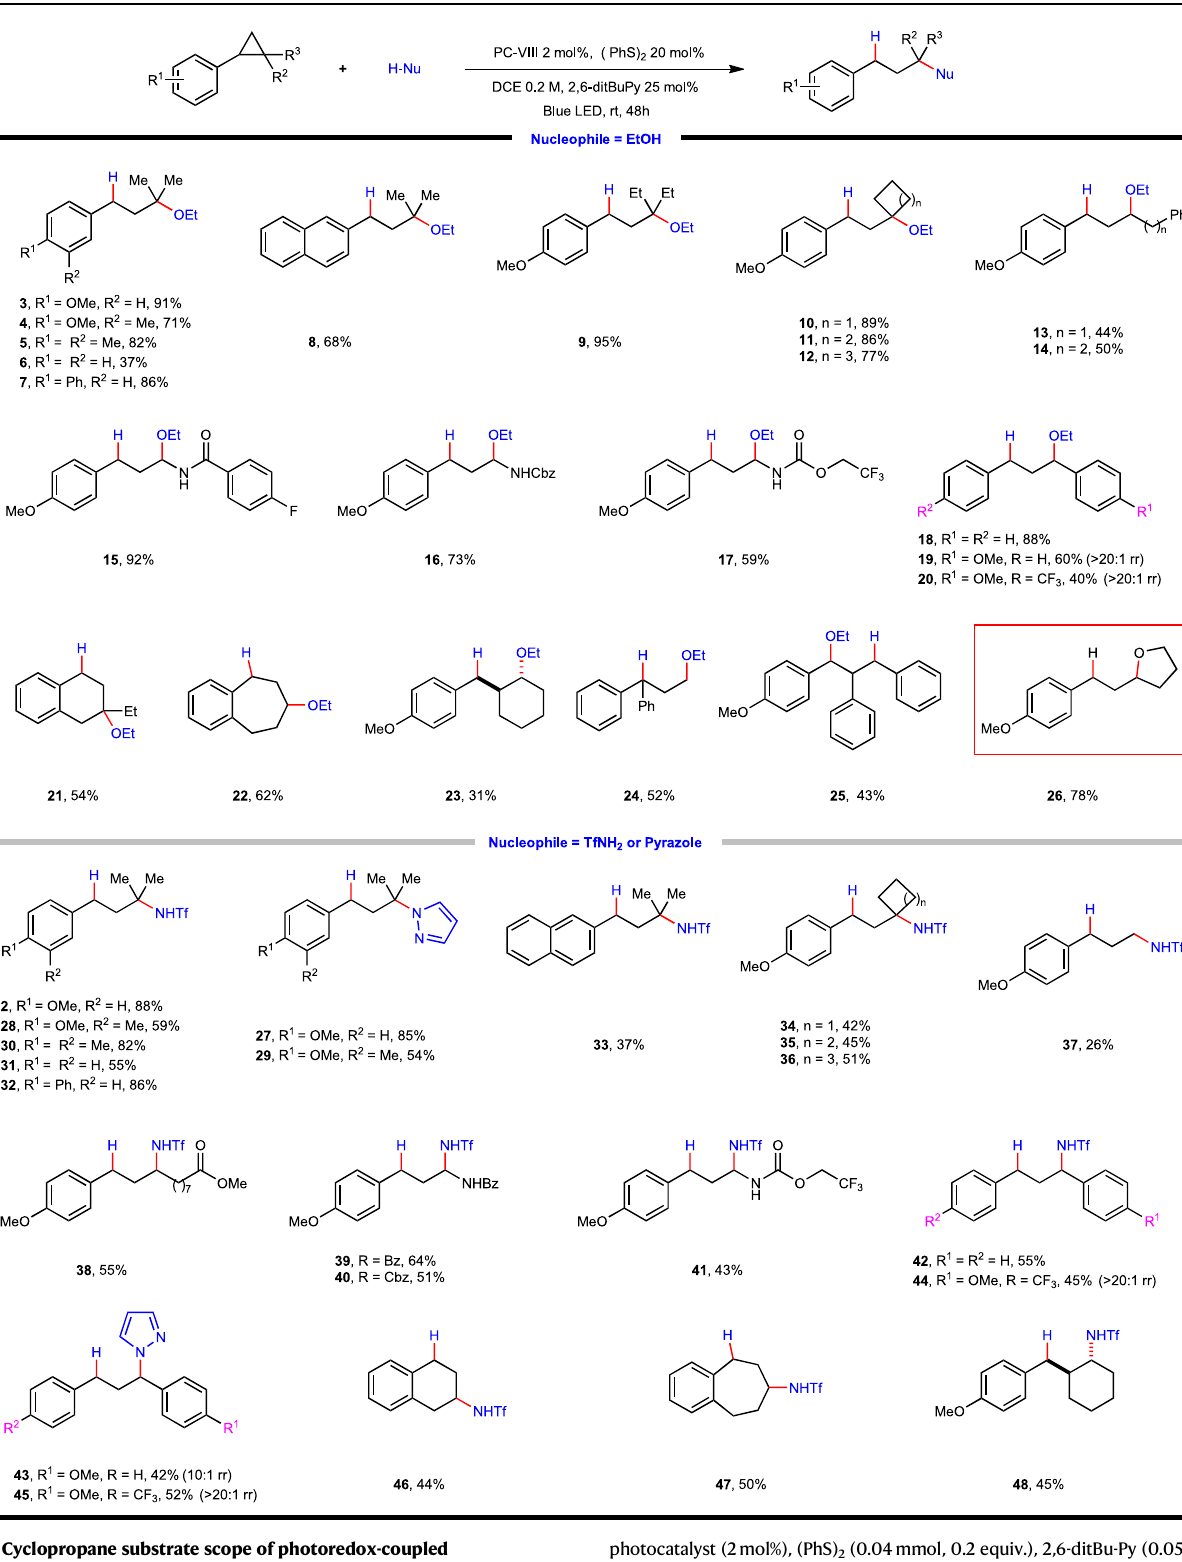
Fig. 2 | Cyclopropane substrate scope of photoredox-coupled C( sp 3 ) – heteroatom bond formation. Reaction conditions: arylcyclopropane (0.2mmol, 1 equiv.), EtOH (2mmol, 10 equiv.) or TfNH 2 (0.3mmol, 1.5 equiv.),